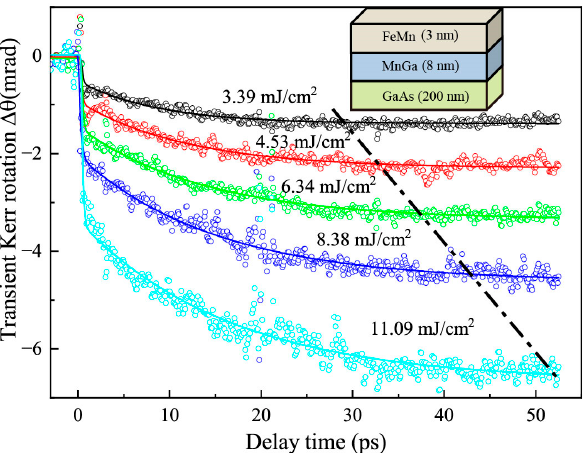
Figure 2. The pump–fluence dependence of TR-MOKE measurement in an FeMn/MnGa layered structure. The scattered open circles are Kerr signal measurements. The solid lines are the fittings to experimental profiles with a double exponential sum function described in the text (Equation (1)). The dot-dashed line joins the maximum demagnetization points at different pump fluence levels.